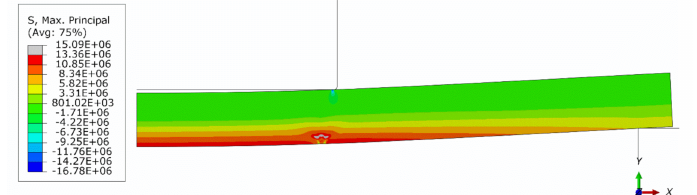
Figure 16. Contour plot of maximum principal stress after failure (axisymmetric model, global mesh size: 0.5 mm); deformed configuration; displacements scaled 10 times.